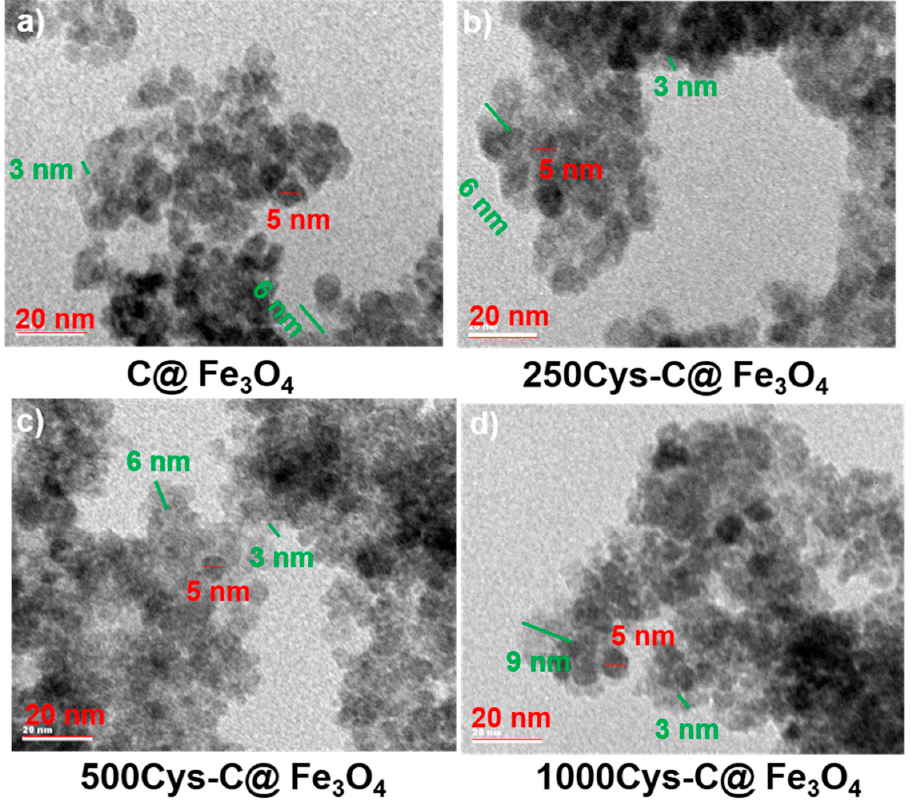
3 O 4 , ( b ) C@Fe 3 O 4 , and ( c ) C@Fe 3 O 4 .